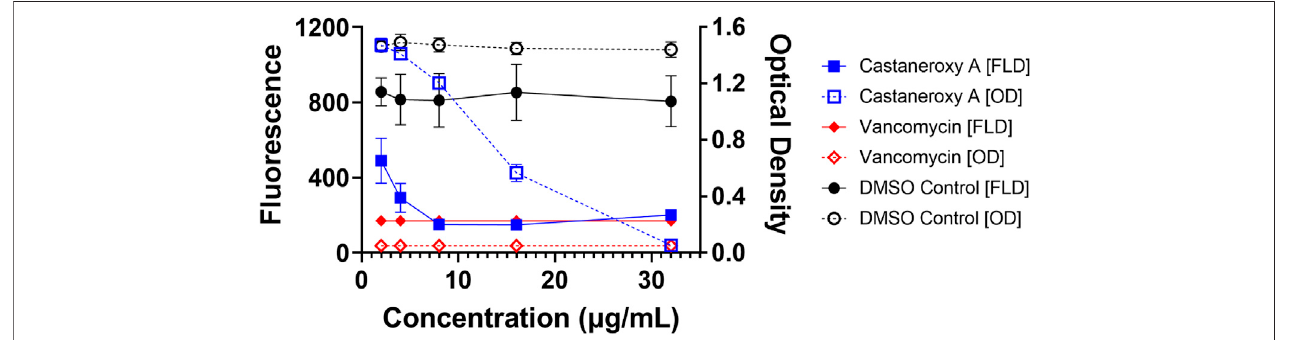
FIGURE 6 | Higher concentrations of castaneroxy A inhibit reporter strain growth after exponential phase growth. The agr I reporter AH1677 was examined up to 8 h in a concentration-dependent test with vehicle (DMSO), positive control (vancomycin), and castaneroxy A. All dashed lines represent optical density (OD) values, indicating growth; all solid lines represent fl uorescence detection (FLD) values, indicating intensity of YFP detection as a result of agr ::P3 activation. Fluorescence and optical density measurements shown here are from 8 h post-inoculation in a Stuart shaker at 37 ° C at 1,000 rpm, with raw data values reported here. These data ( n (cid:1) 9) represent three independent experiments with three technical replicates.